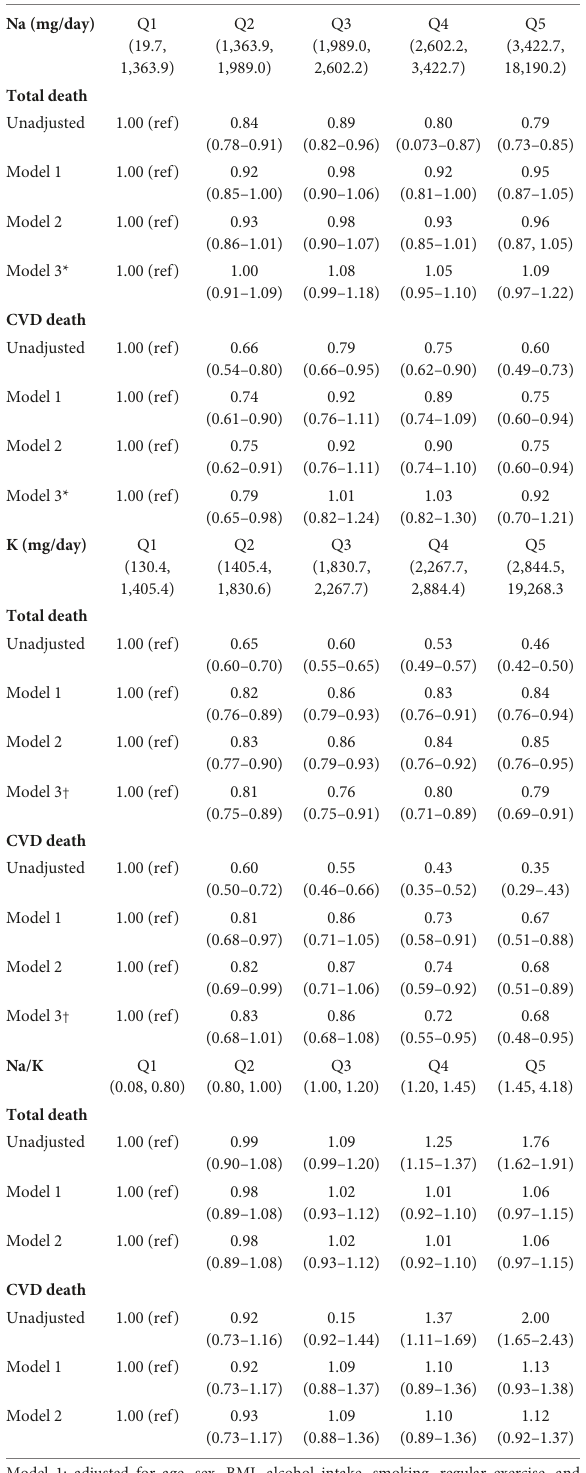
TABLE 2 Multiple Cox proportional hazard regression analysis for total death and CVD death according to sodium (Na), potassium (K) and sodium to potassium (Na/K) ratio